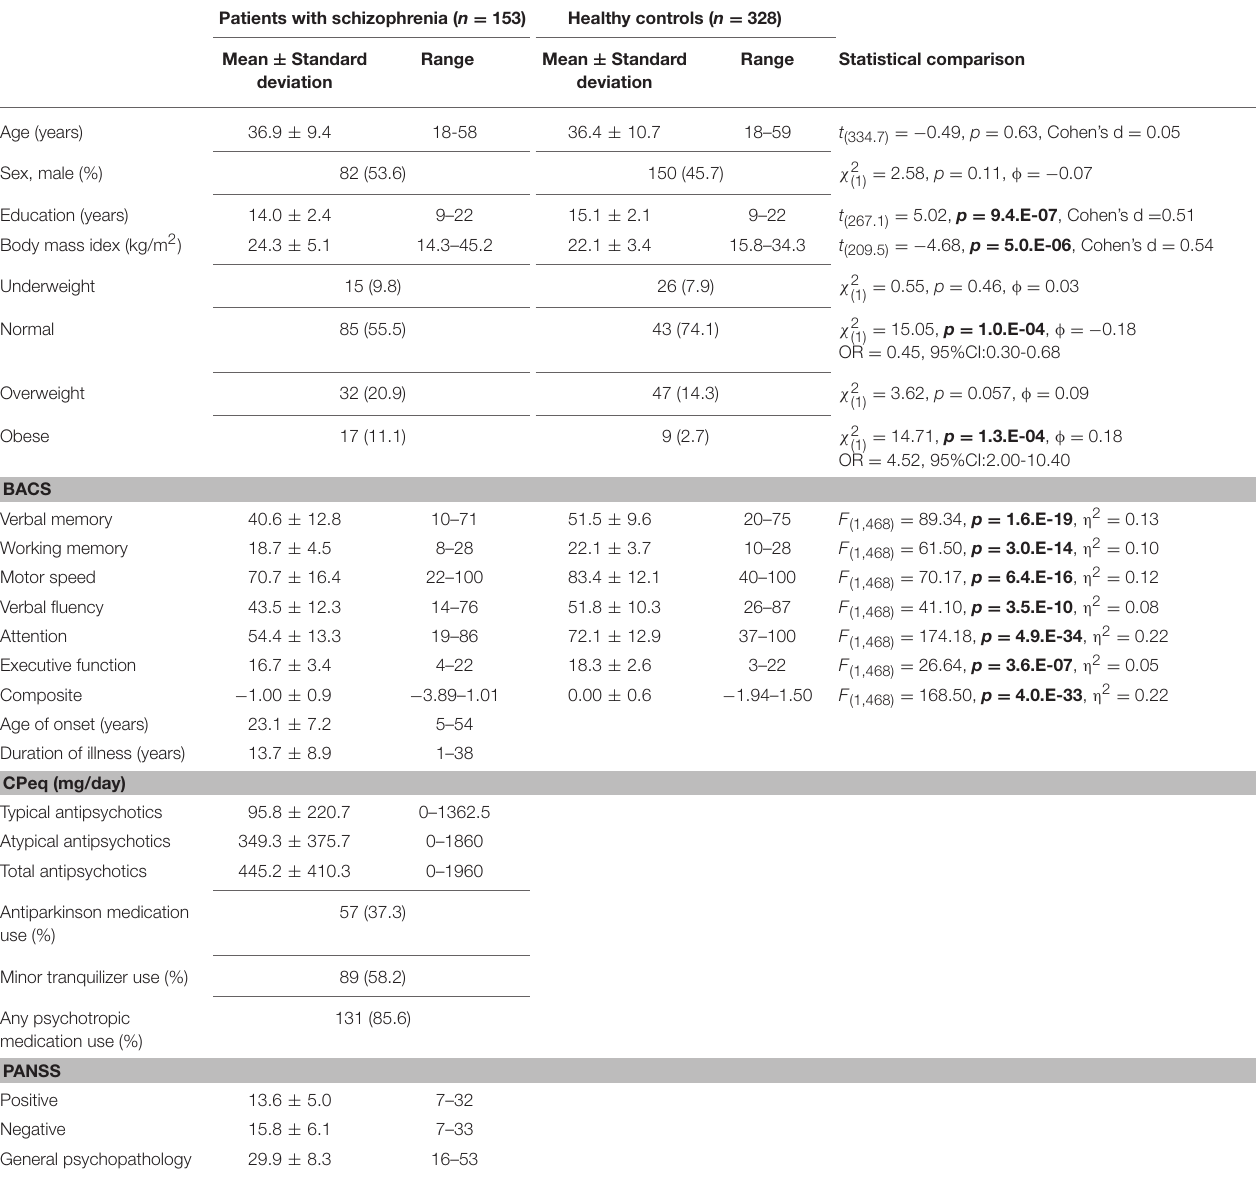
TABLE 1 | Demographic and clinical characteristics of the participants. Patients with schizophrenia ( n = 153) Healthy controls ( n = 328) Mean ± Standard Range Mean ± Standard Range Statistical deviation deviation